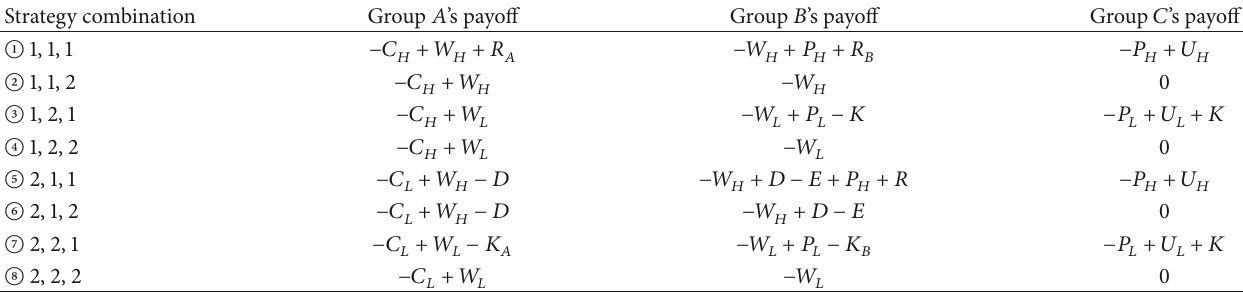
Table 1: Payoff matrix of agri-food quality